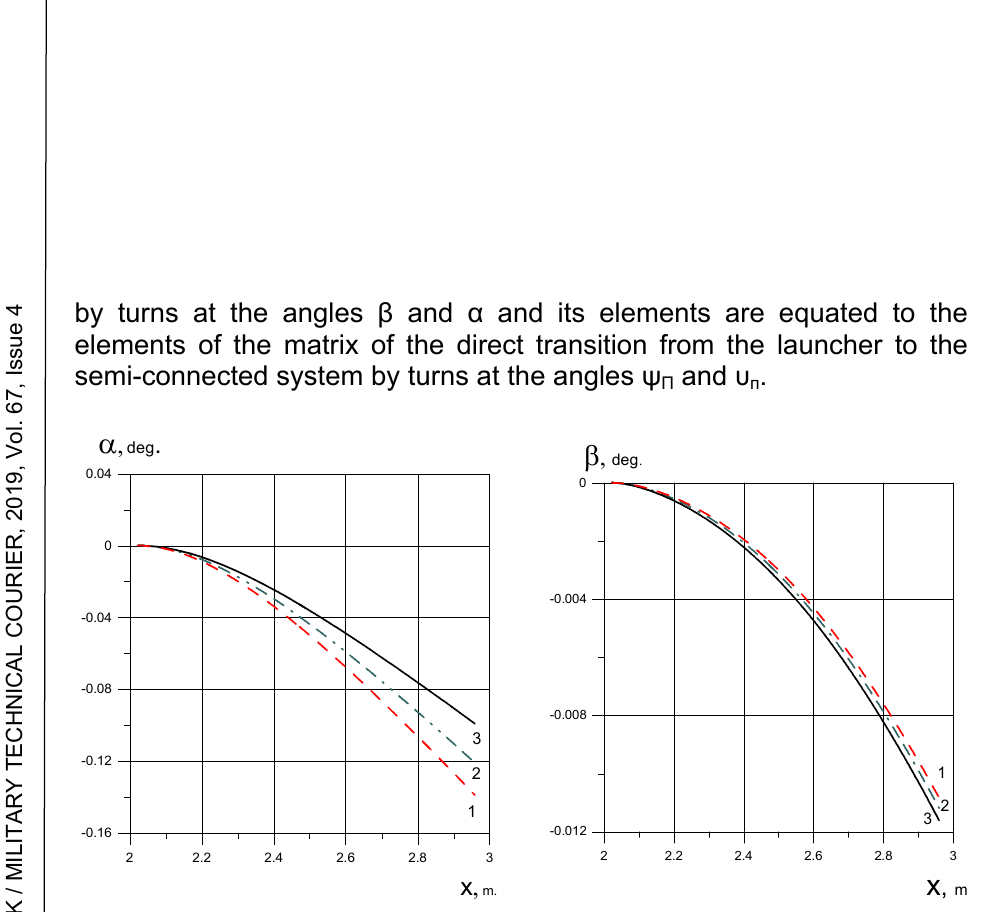
Figure 10 – Calculated values of the angle of attack α and the angle of slip β of the projectile along the length of the section x of spatial motion at different elevation angles θ